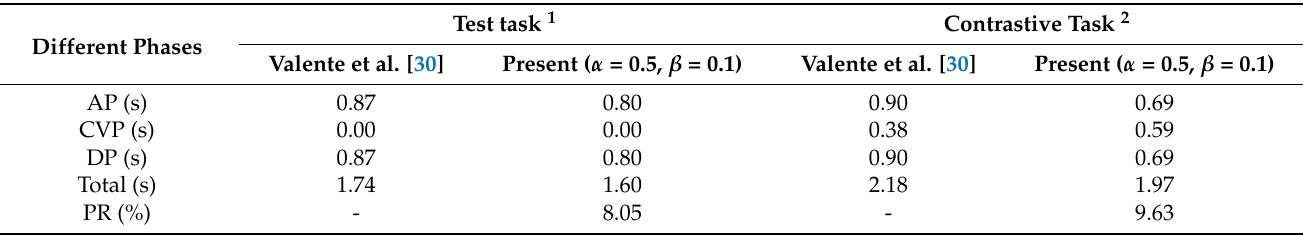
Table 3. The elements of the execution time for two tasks.